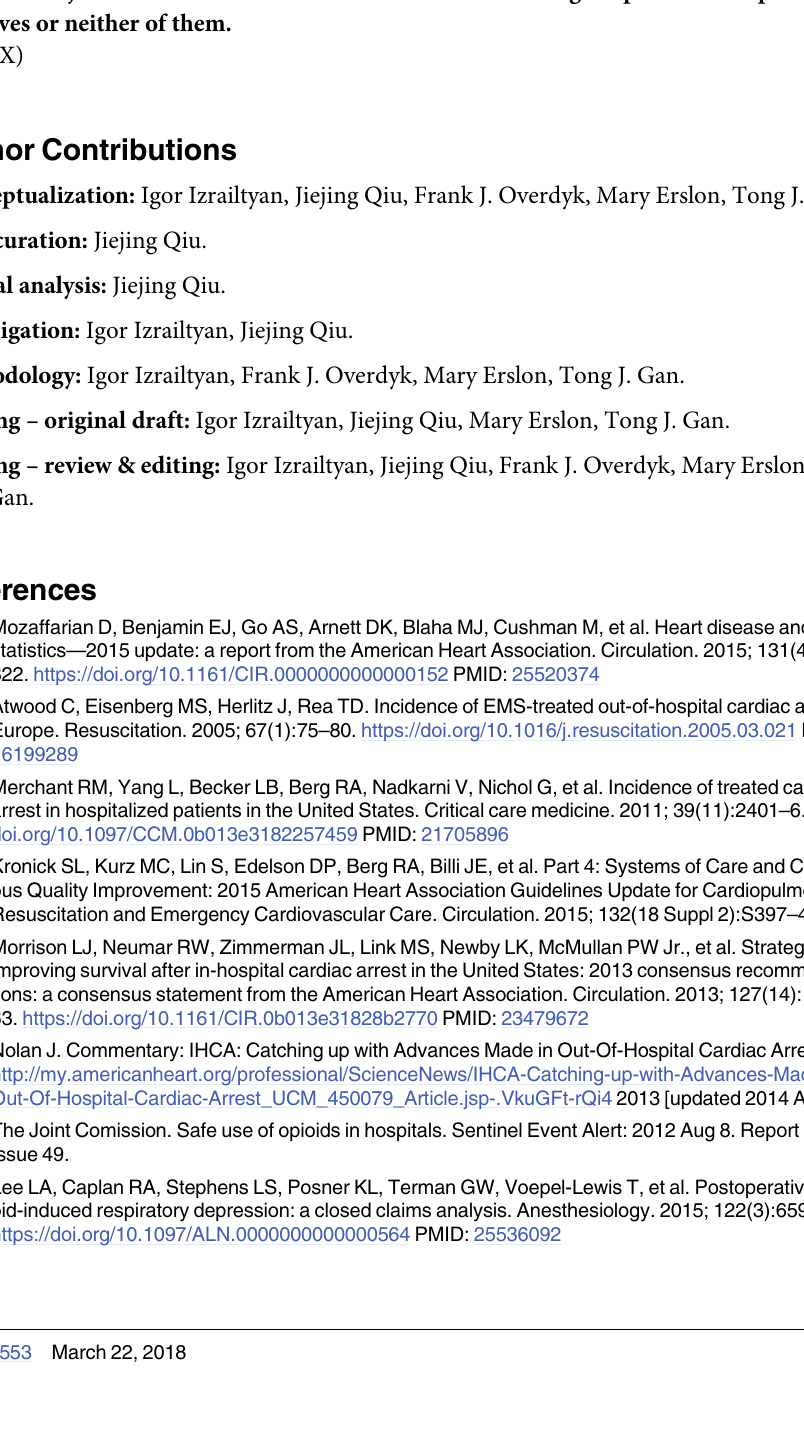
S1 Table. Exclusionary ICD-9-CM codes. S2 Table. Types of medications included in the study. S3 Table. Demographic, clinical, and provider characteristics in studied medical and surgi- cal inpatients. S4 Table. Adjusted odds ratios for CPRA for medical and surgical patients on opioids and sedatives or neither of